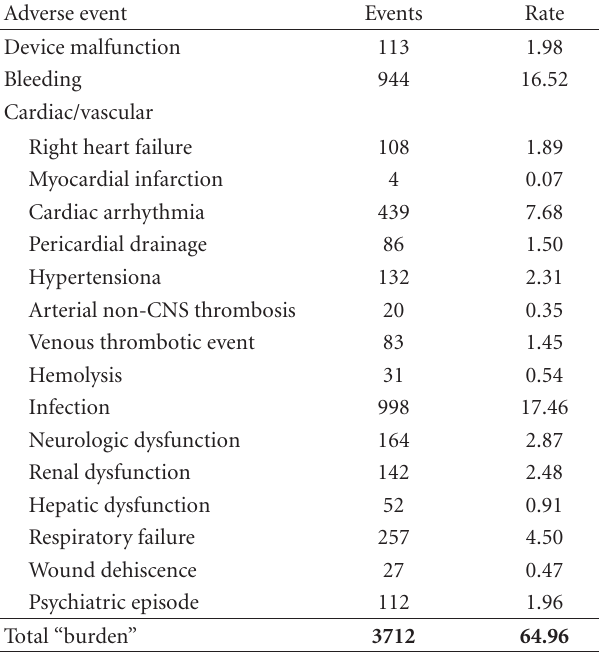
Table 3: Adverse events rates (Events/100 patient-months) in first 12 months after implant for 1092 primary LVADs (INTERMACS: June 2006–March 2009, with permission from: Second INTERMACS annual report )